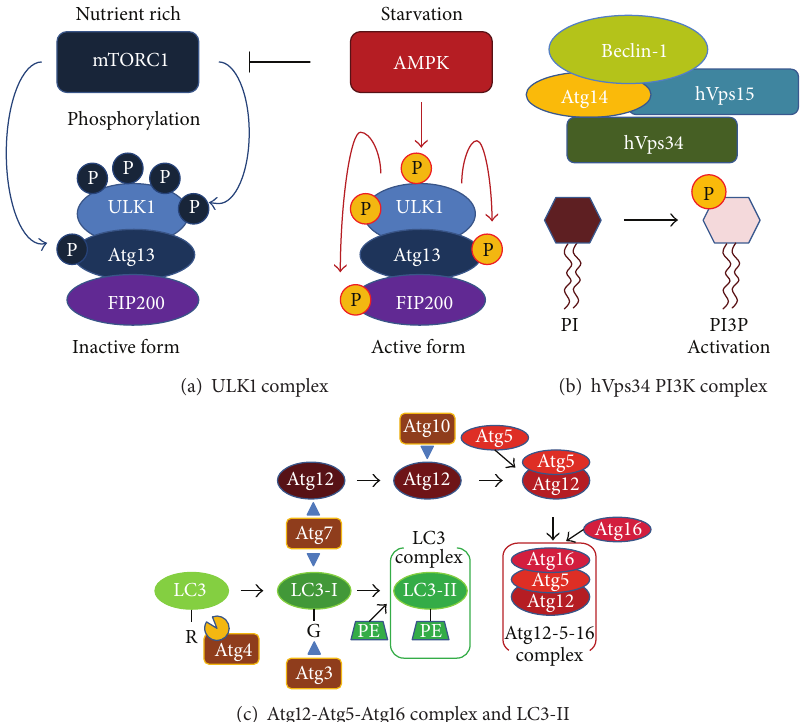
Figure 2: Autophagy regulation. (a) ULK1 protein kinase complex. ULK1 is a critical regulator of nutrient-related autophagy. mTOR- dependent phosphorylation of ULK1 (Atg1) and Atg13 under nutrient-rich conditions inhibits autophagy. In contrast, AMPK-dependent phosphorylation of ULK1 activates autophagy induction under energy-depleted condition. (b) PI3K complex. Phosphatidylinositol 3-kinase (PI3K) phosphorylates phosphatidylinositol in the membrane lipid to create phosphatidylinositol 3-phosphate. Class III PI3K comprises hVps34,hVps15,Beclin-1,andAtg14.(c)Atg12-Atg5-Atg16complexandLC3-II.Unlikeotherubiquitin-likeproteins,theubiquitin-likeprotein Atg12 has a C-terminal glycine, which protects it from processing. Atg12 is conjugated to the substrate Atg5 by Atg7 and Atg10. The Atg12- Atg5 conjugate forms a complex with Atg16. Self-oligomerization of Atg16 results in a multimer of the Atg12-Atg5-Atg16 complex. After the ubiquitin-like protein LC3 has had its C-terminal arginine residue cleaved by the cysteine protease Atg4, it is passed on to Atg7 and Atg3 and transferred into the head group of its substrate phosphatidylethanolamine (PE). This LC3-PE conjugate functions as part of the membrane component of the autophagosome. When LC3-PE is once again deconjugated to PE by Atg4, Atg8 is